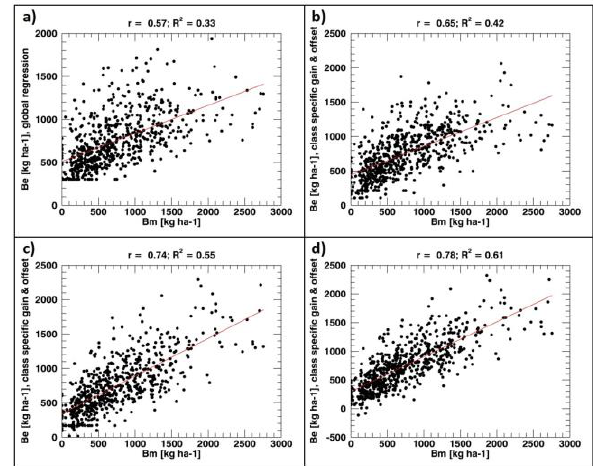
Figure 7. Scatterplot of B m and B e for different aggregation levels of the regression model. a) global, b) agroeco, c) department, d)